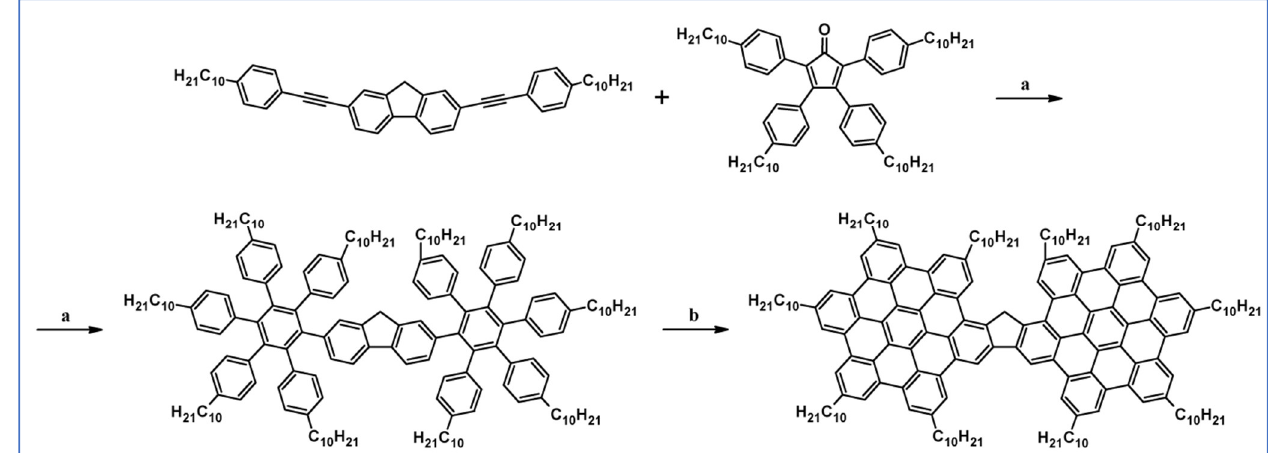
Scheme 167. DA cycloaddition and Scholl reaction for the synthesis of Super-oligophenylene dimer with fluorene linker (“Superfluorene”) [219]. Reagents and conditions: a = Ph 2 O, rfx, 19 h, Y = 27%; b = next step (Scholl reaction).